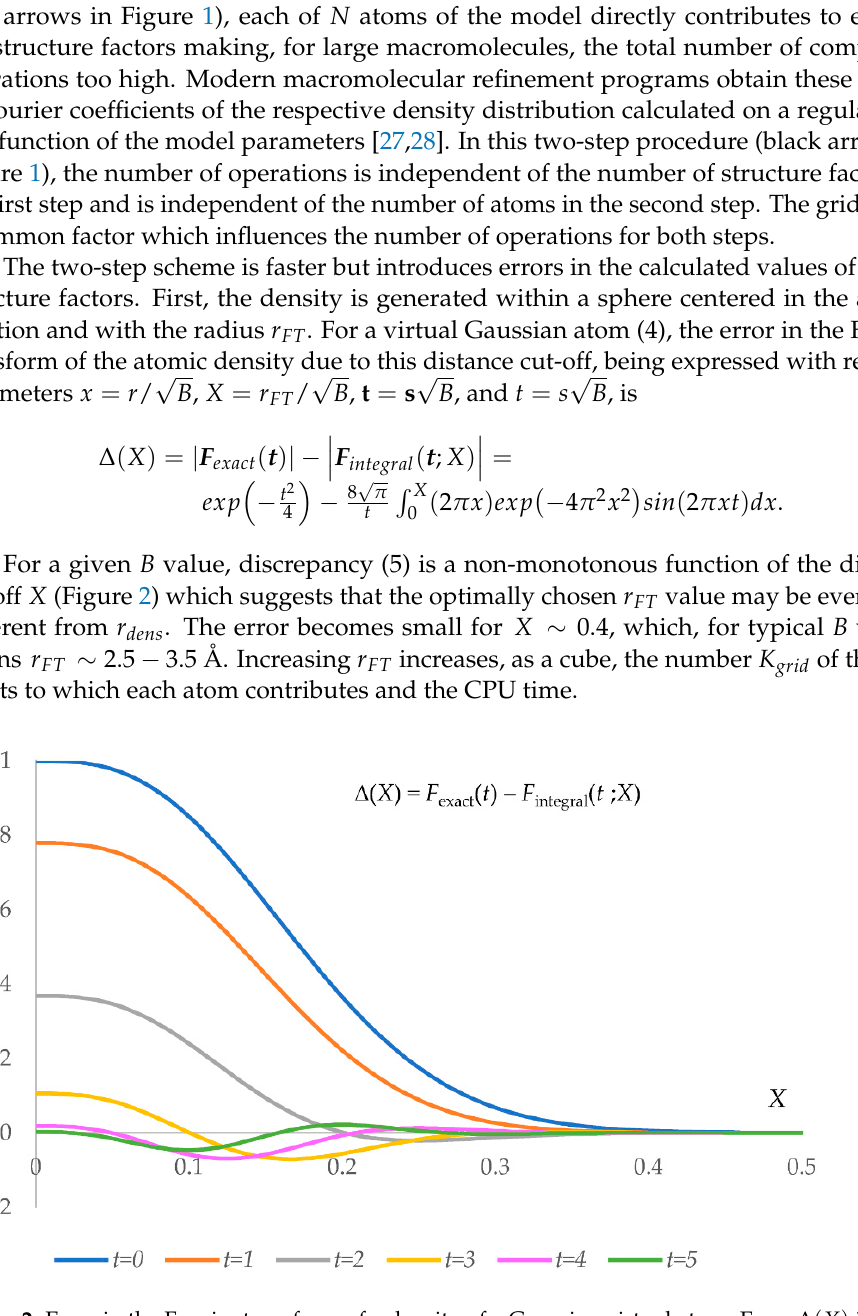
Figure 2. Error in the Fourier transform of a density of a Gaussian virtual atom. Error ∆ ( X ) is given as function (5) of the dimensionless truncation radius, X = r FT /√𝐵 , and for different values of the parameter t = s√𝐵 . ∆(cid:4666)0(cid:4667) is equal to the exact value |𝐅(cid:4666)𝒔; 𝑩(cid:4667)| for the respective 𝑠√𝐵 .